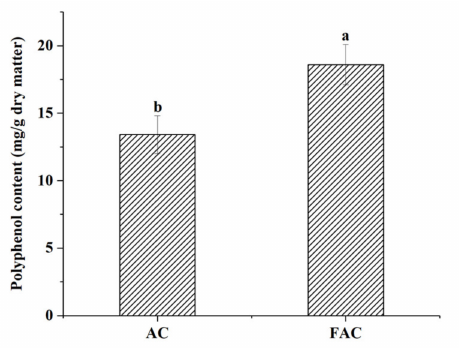
Figure 1. The polyphenol content of AC before and after fermentation. ab p < 0.05 compared between AC and